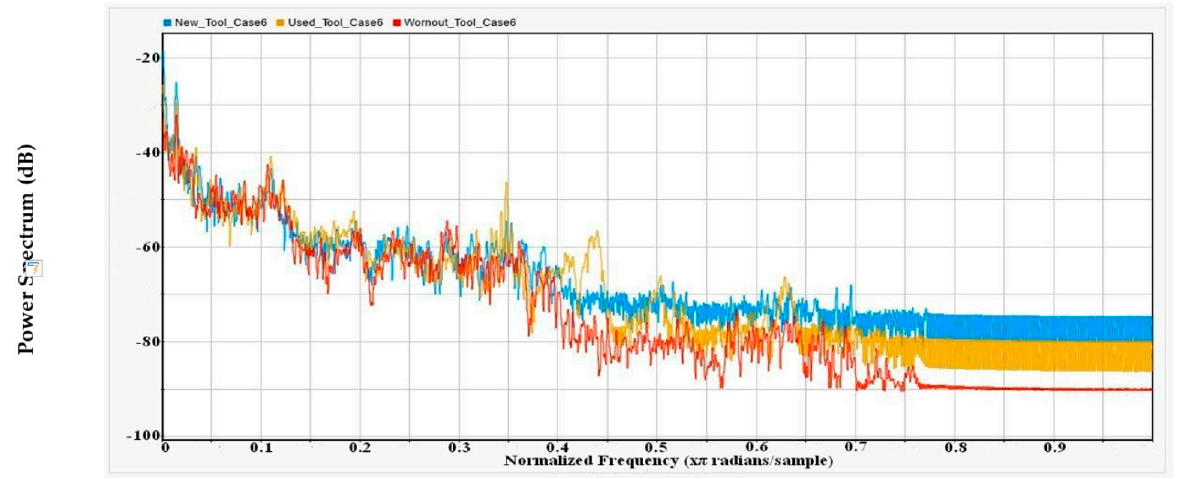
Figure 20. Power spectral density (PSD) for Case-5 of new (blue), used (yellow), and worn-out (red) tool with maximum leakage settings.